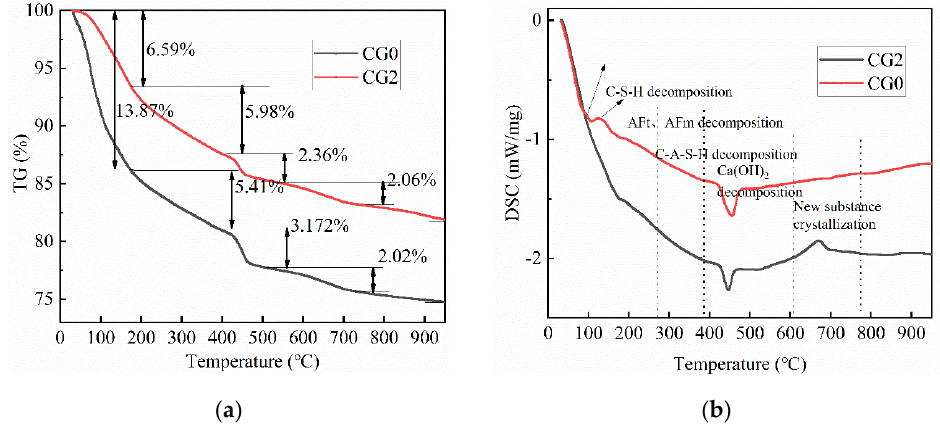
Figure 15. TG-DSC curves for ferrochrome slag concrete: ( a ) TG curve; ( b ) DSC curve.